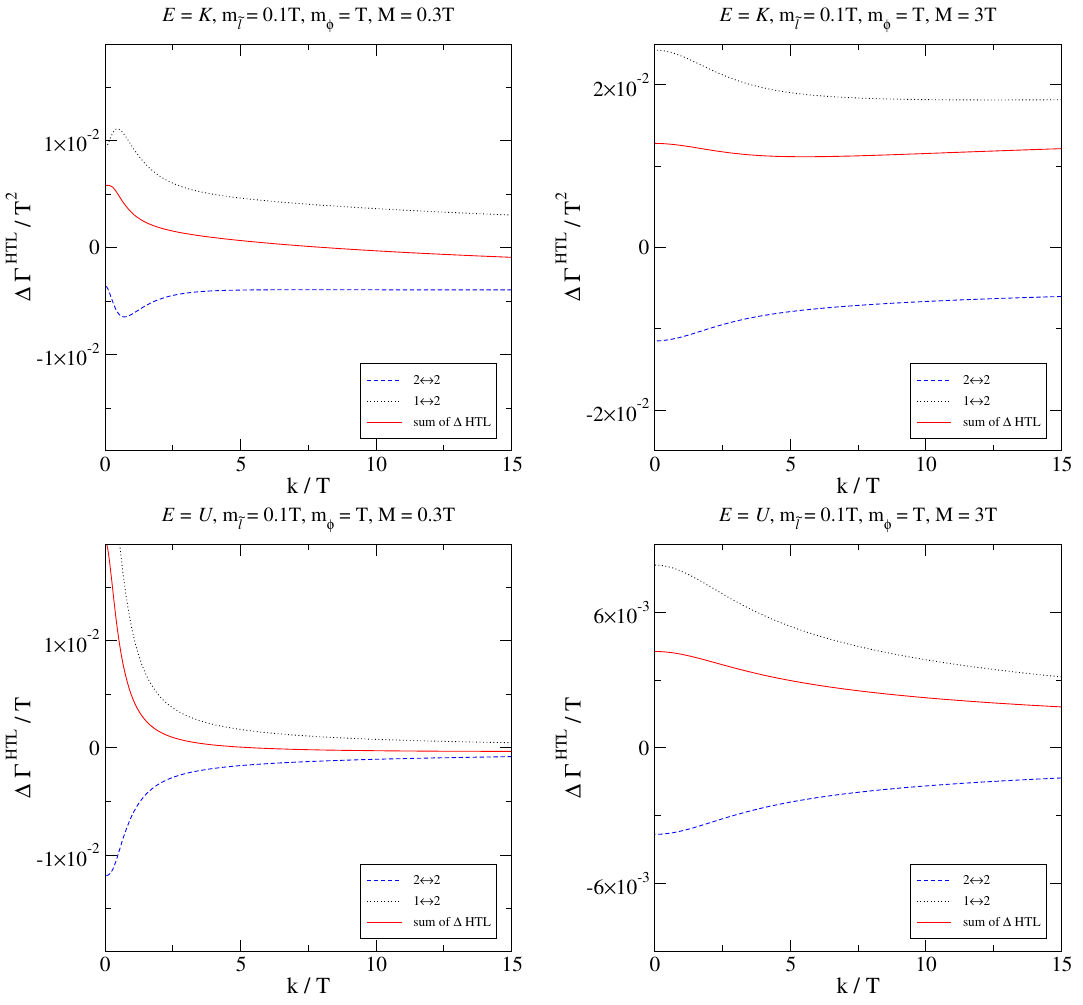
, from eq. (5.11), and ∆Γ HTL , from Figure 3 . Examples of a numerical evaluation of ∆Γ HTL 2 ↔ 2 1 ↔ 2 eq. (5.14), for M = 0 . 3 T (left) and M = 3 T (right). The top row shows results for E = K (normalizing to T 2 ), the bottom row for E = U (normalizing to T ), with the other parameters explained at the end of section 6. The purpose of these corrections is to replace the auxiliary mass m = 0 . 1 T through the physical thermal lepton mass m ≈ 0 . 3 T , which parametrizes HTL ˜ ‘ ‘T propagators. The 2 ↔ 2 and 1 ↔ 2 corrections depend strongly on the IR regulator m , however ˜ ‘ the full result (solid line) is almost independent of it, as long as we stay away from the constrained domain M ∈ ( m + m ) − m , m ˜ ‘ ˜ ‘ φ φ